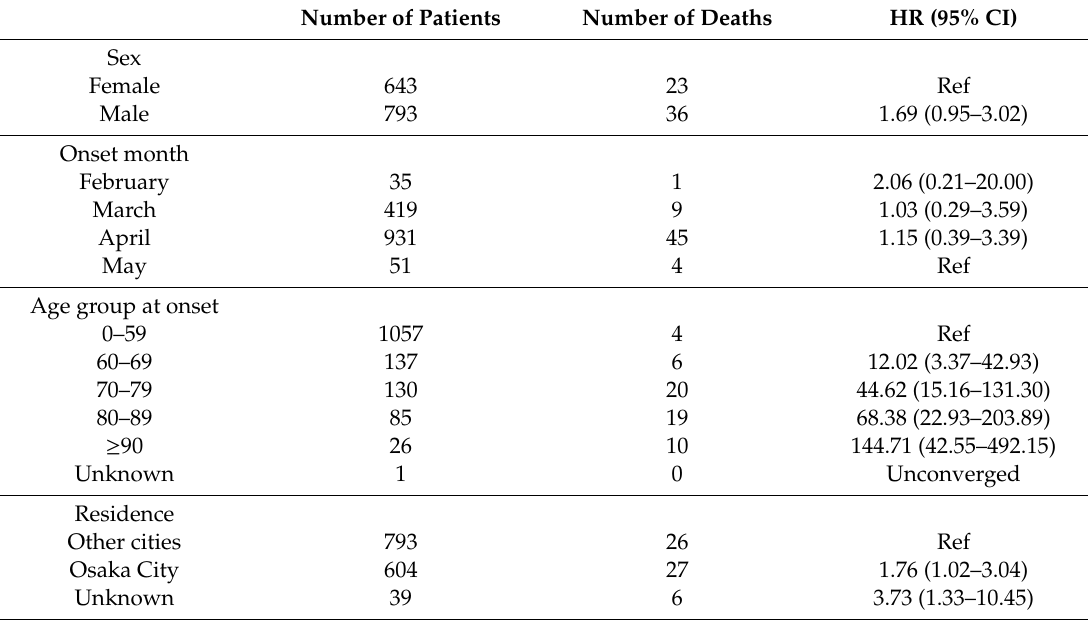
Table 4. Results of Cox regression analysis in the present